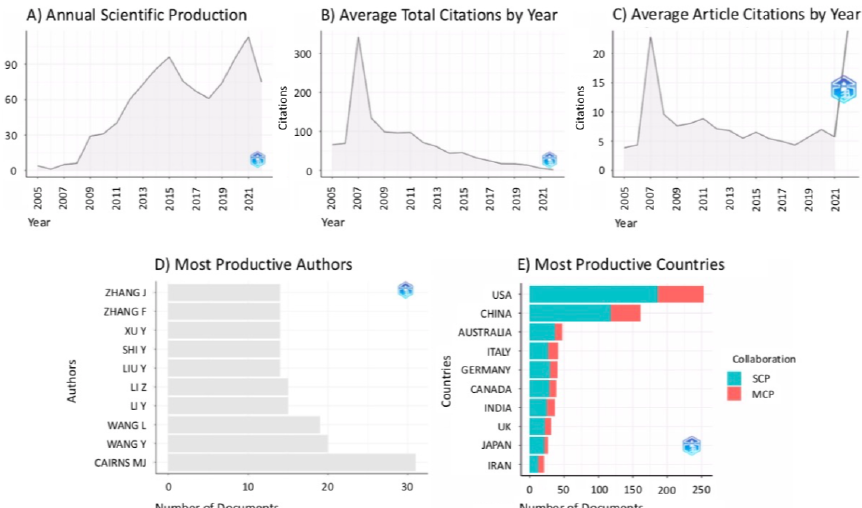
Figure 2. Graphical results of the bibliometric analysis on the citing references by means of the bibliometrix package for R [17]. ( A ) Annual scientific production in terms of the number of published documents by year. ( B ) Average total citation obtained by year. ( C ) Average article citations by year. ( D ) Ten most productive authors in the downloaded sample of documents. ( E ) Most productive countries in the downloaded sample of documents. In the plot, the type of collaboration is indicated by colour, with single country publications (SCP) in light blue and multiple country publications (MCP) in red.